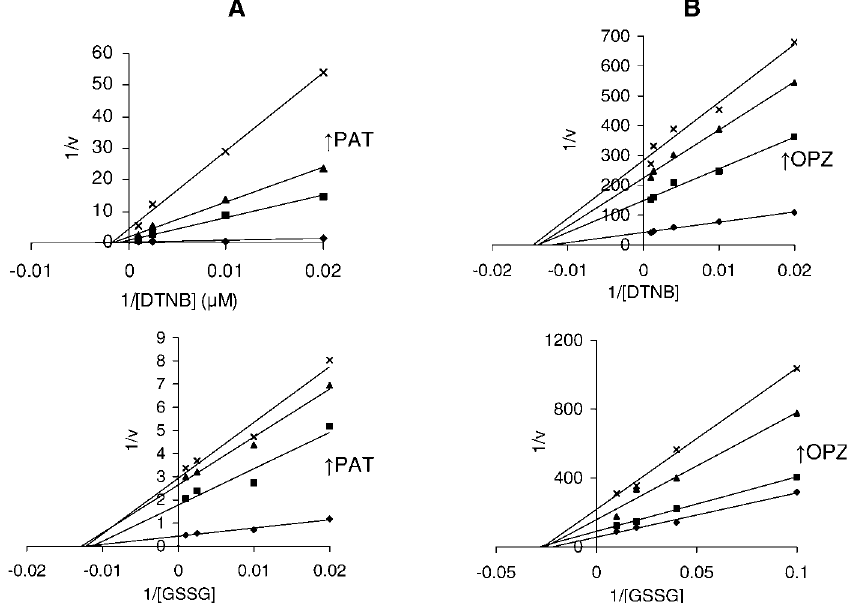
Figure 3. Inhibition of S. mansoni TGR by PAT and OPZ Reciprocal plots showing inhibition of the TrxR and GR activities of TGR by PAT (A) and OPZ (B). Both are noncompetitive inhibitors, altering the V max while the K m for substrates remains constant. The apparent V max for various concentrations of inhibitors were used to calculate K i values. Concentrations of PAT are no drug ( ¤ ), 10 nM ( & ), 30 nM ( m ), and 75 nM ( 3 ); and of OPZ are no drug ( ¤ ), 50 l M ( & ), 75 l M ( m ), and 100 l M ( 3 ). Concentrations of DTNB ranged from 50 to 1,000 l M (TrxR activity) and of GSSG from 10 to 100 l M (GR